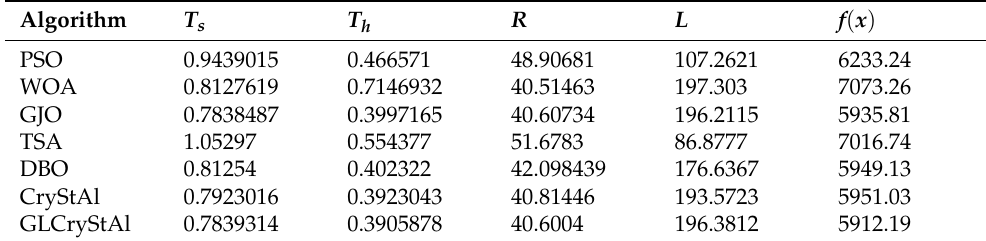
Table 9. The best results of six